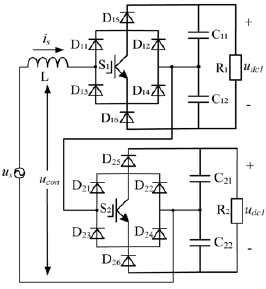
Figure 6. Single-phase two-stage cascaded VIENNA rectifier for TCMC.